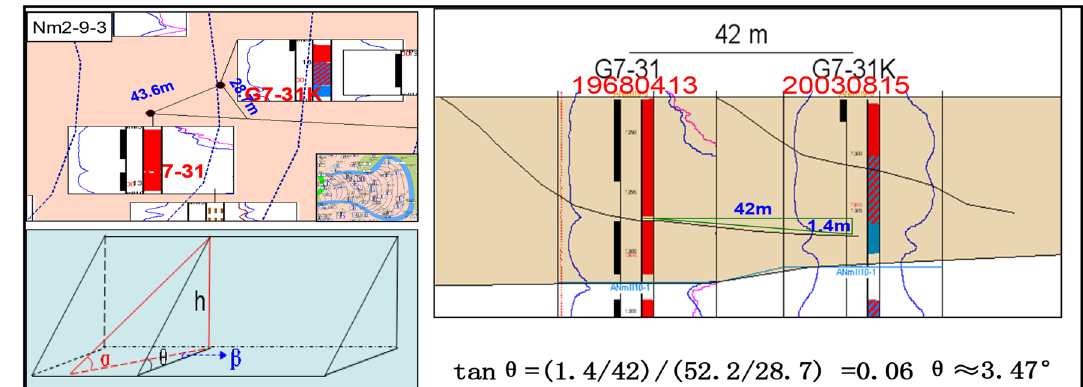
Fig. 14 Calculation chart of lateral mudstone formation in wells G7-31 and G7-31K